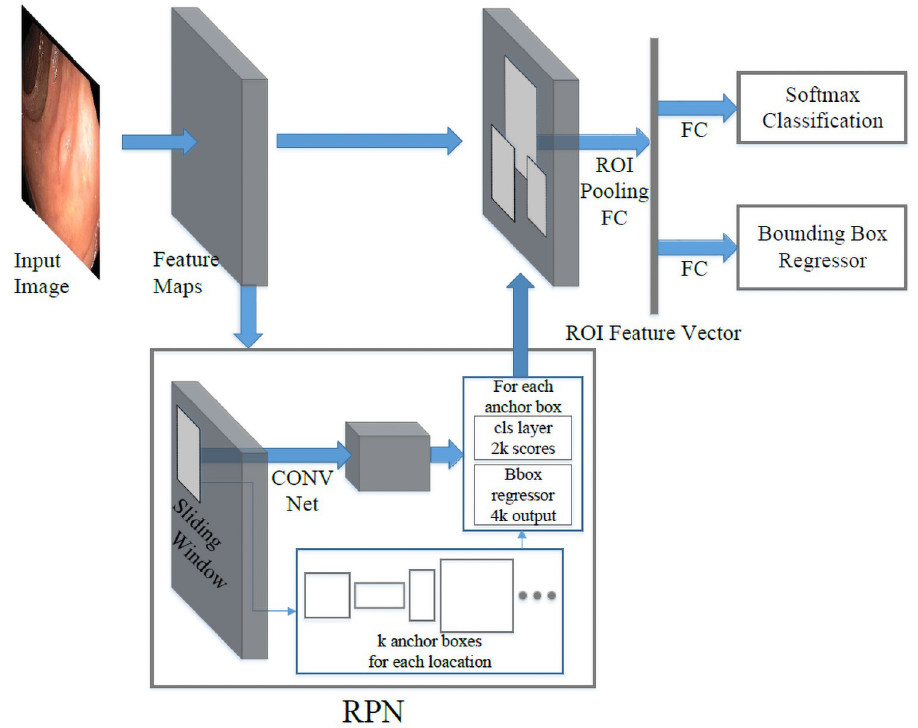
Fig 1. Faster R-CNN structure. Region proposal network (RPN) shares the same base CNN with a fast R-CNN network. The region proposal is generated by sliding a small convolutional network over the shared feature maps, and these proposals are used to produce final detection